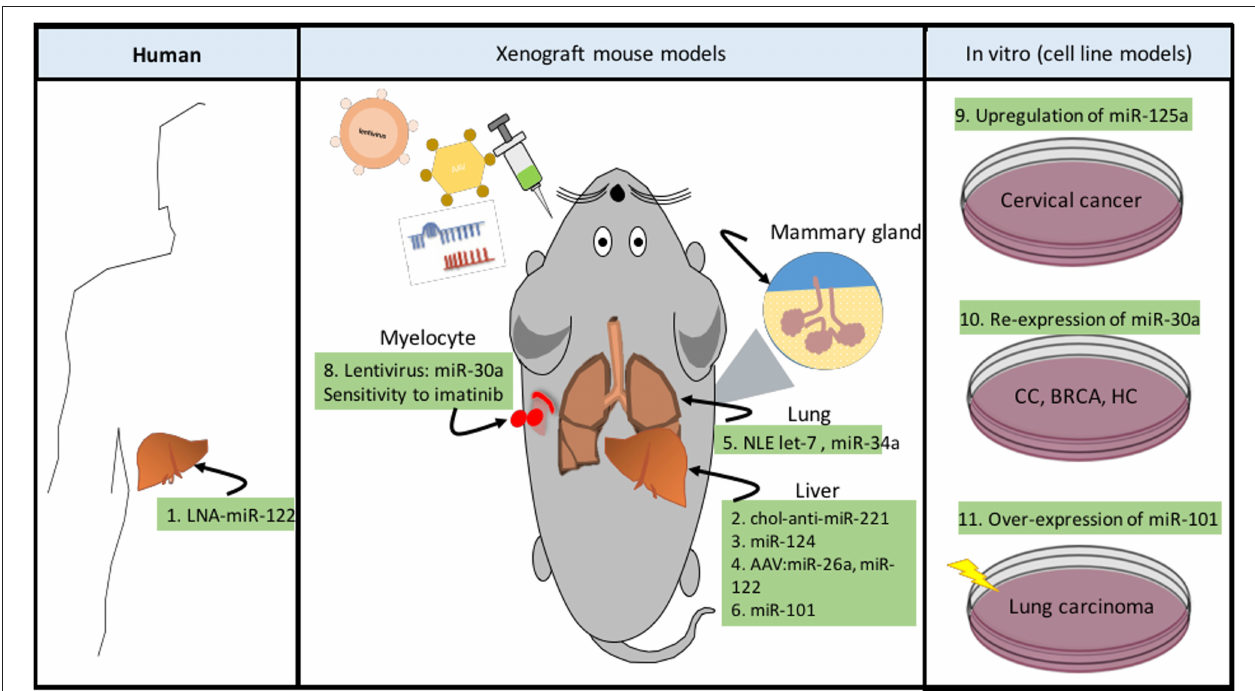
FIGURE 5 | ncRNAs as novel therapeutic strategies in cancer metabolism. Targeting cancer metabolism represents a novel resource to develop anti-cancer therapies. Now a days, there are different techniques developed to specifically modulate metabolic pathways, some of them are dedicated to silencing (LNA) or re-expressing (miRNA mimic) ncRNA transcripts ( Phan et al., 2014). These systems can be delivered by intratumoral, intraperitoneal, and intravenous injections, through systemic adenovirus-associated virus (AAV), or in complexes with neutral lipid emulsions ( Drakaki et al., 2013). In addition to these technologies, cholesterol-modified miRNAs (chol-anti-miRs) exhibit improved pharmacokinetics and antitumor efficacy. Human (1) The development of hepatocellular carcinoma (HCC) in persons who are persistently infected with hepatitis C virus (HCV) is a growing problem. A phase II trial of the LNA anti-miR-122 is being carried out for treatment of HCV infection ( Lindow and Kauppinen, 2012). Xenograft mouse models (2) chol-anti-miR-221 effectively suppresses liver tumor growth (Park et al., 2011). (3) Systemic administration of miR-124 suppresses liver cancer growth through suppression of the IL6/STAT3 inflammatory pathway (Hatziapostolou et al., 2011). (4) AAV delivery of miR-26a or miR-122 suppresses MYC -driven liver carcinogenesis without affecting normal hepatocytes (Kota et al., 2009; Hsu et al., 2012). (5) Neutral lipid emulsions (NLE) to deliver let-7 which targets RAS and MYC oncogenes, as well as miR-34, reduces tumor size in lung cancer (Trang et al., 2011). (6) miR-101 and miR-376b are miRNAs, which negatively regulate the autophagy pathway ( Frankel et al., 2011; Korkmaz et al., 2012). Furthermore, overexpression of miR-101 suppressed tumor development and efficiently reduced tumor size in liver cancer (Su et al., 2009). (7) Over-expression of miR-101 can effectively reduce tamoxifen-induced autophagy and enhance the sensitivity of breast cancer cells to tamoxifen treatment (Frankel et al., 2011). (8) Recombinant lentivirus administration of miR-30a (inhibitor of autophagy by down-modulating BECN1), can enhance sensitivity to imatinib cytotoxicity in chronic myeloid leukemia, increasing tumor cell apoptosis (Yu et al., 2012). In vitro (cell line models). (9) Up-regulation of miR-125a in cervical cancer (CC) models sensitized to paclitaxel by down-regulating STAT3 ( Fan et al., 2016). (10) Re-expression of miR-30a can sensitize tumor cells to cisplatin via mediating autophagy in HeLa, MCF-7 and HepG2 (Zou et al., 2012).